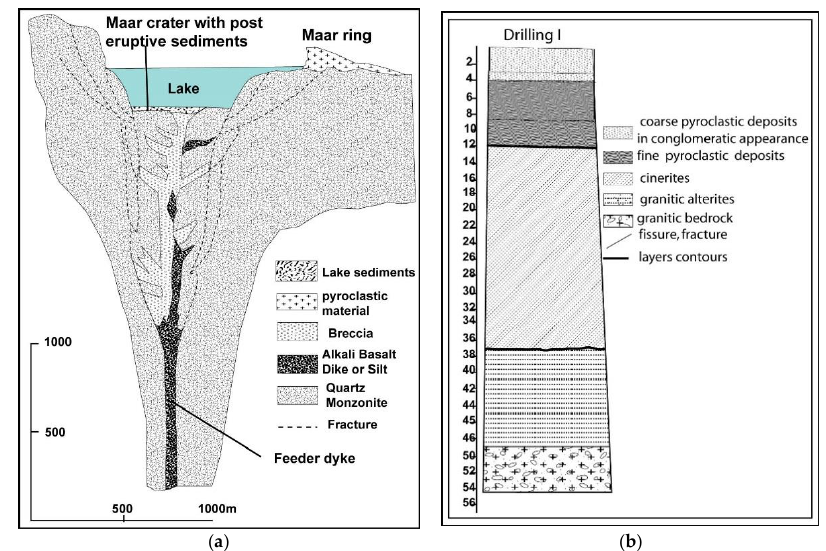
Figure 11. ( a ) Lake Nyos soil section (source: [2], modified); ( b ): Drilling on Lake Nyos pyroclastic dam (source: [20,59], modified).